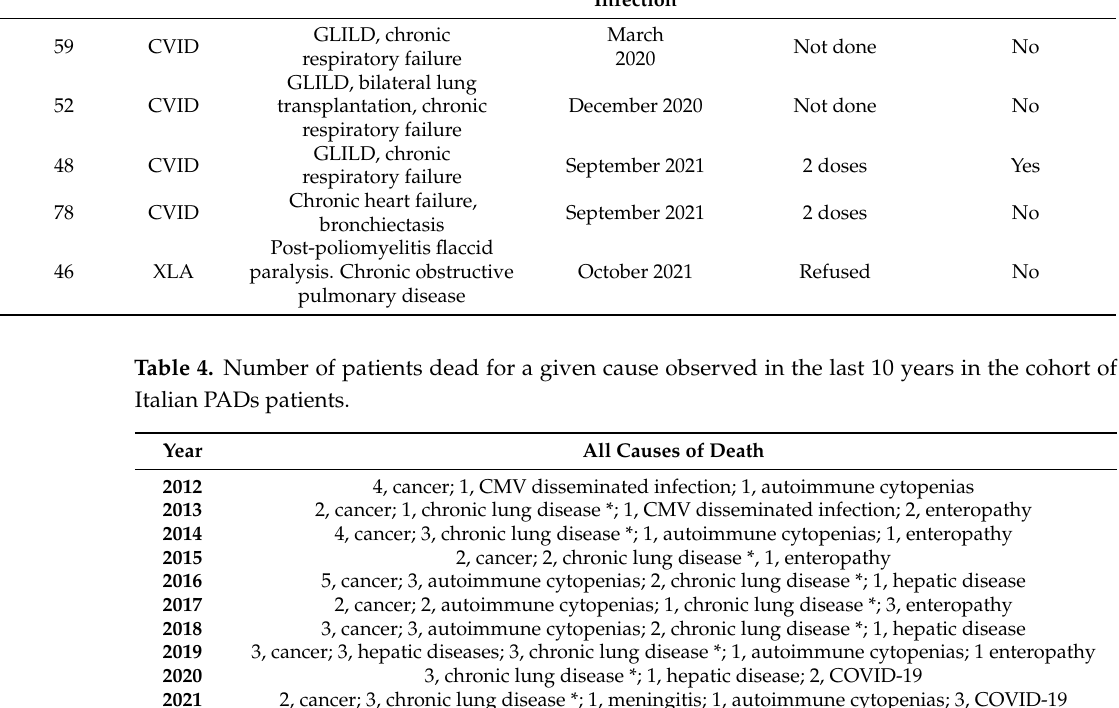
Table 4. Number of patients dead for a given cause observed in the last 10 years in the cohort of Italian PADs patients.